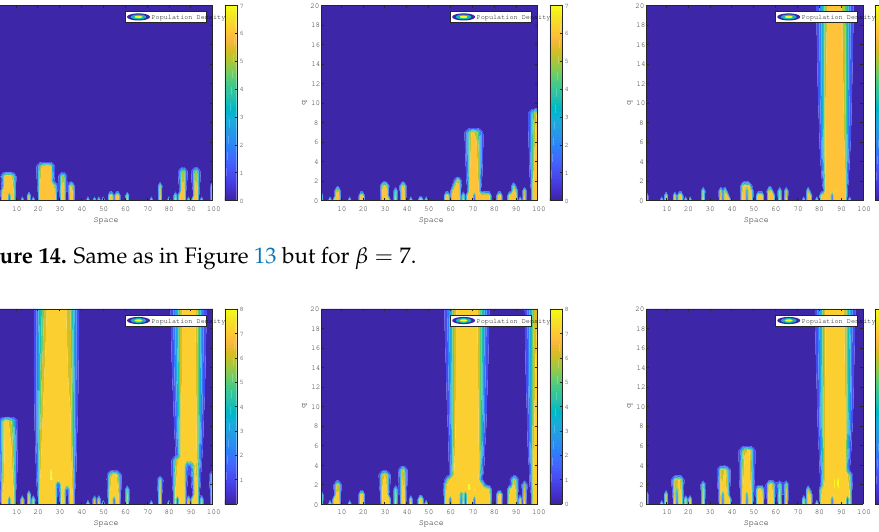
Figure 15. Same as in Figure 13 but for β =